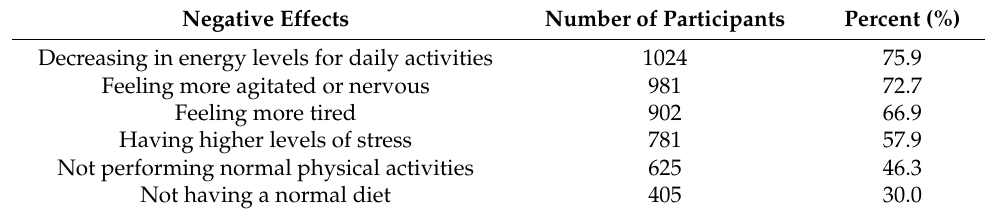
Table 4. Dysmenorrhea and Quality of Life ( n = 1349).